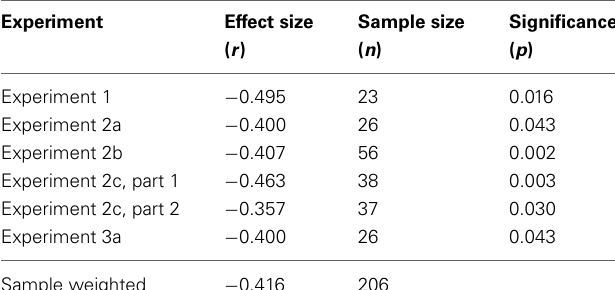
Table 7 | Meta-analysis: Effect of mind-wandering on behavioral outcomes (reading